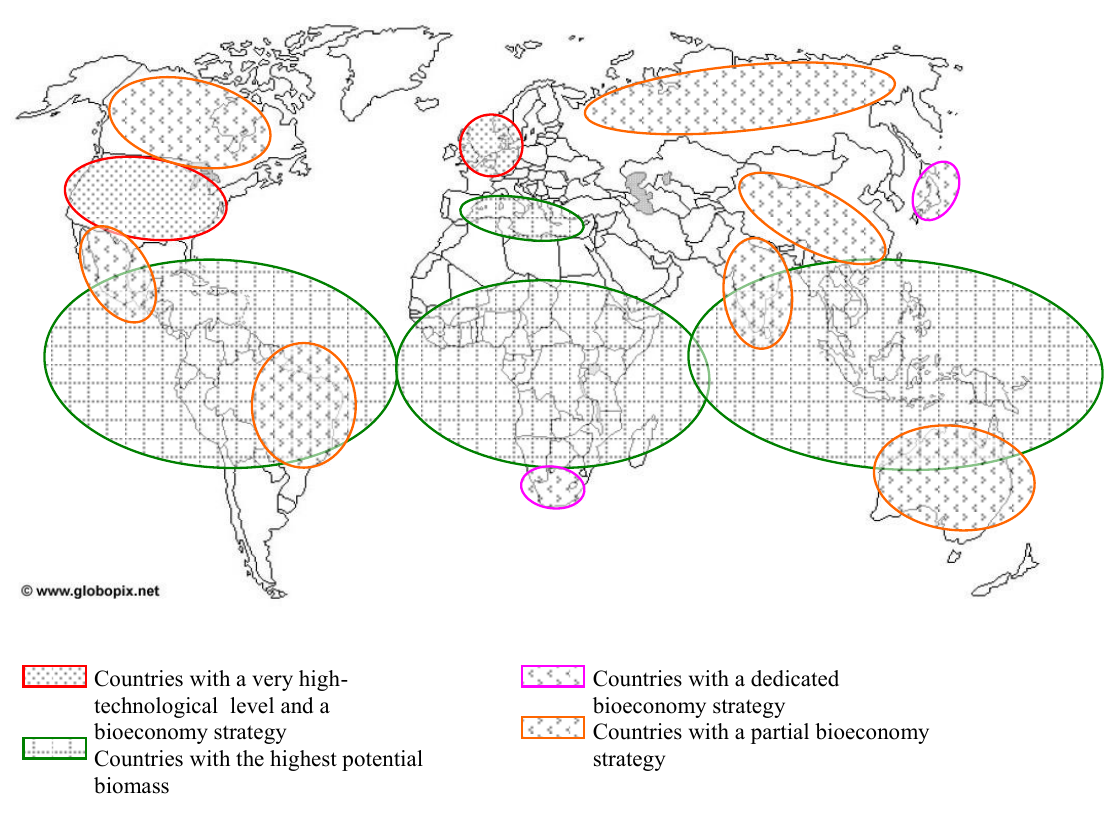
Fig. 6 : The distribution of higher potential biomass and advanced-technological countries. Source: own figure on data by UNEP, 2009; WB, 2011; bio-step.eu/background/bioeconomy-strategies.html